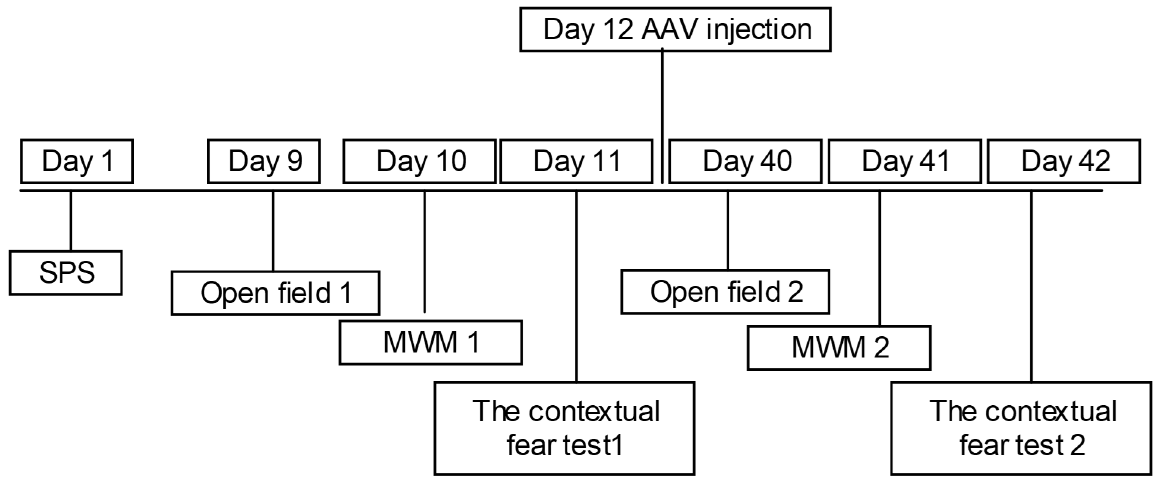
Figure 1. The design of the current study . To investigate whether SPS mice develops PTSD-like behaviors, the mice were randomly divided into sham (n = 18) and SPS (n = 36) groups. Open field test, MWM and contextual fear test were conducted on mice on day 9, 10 and 11, separately, after SPS induction. On day 12, some of the mice (n = 9 in sham group; n = 9 in SPS group) were sacrificed, and the hippocampal tissues were collected to detect the BHLHE40 protein levels. To investigate the functions of BHLHE40 on PTSD-like behaviors of mice, the remaining SPS mice were divided into 4 groups: sham (n = 9), SPS (n = 9), SPS+AAV-NC (n = 9), SPS+AAV-BHLHE40 (n = 9). Some of the mice were injected with AAV-NC and AAV-BHLHE40 on day 12. After injection of AAV for 28, 29, 30 days, open field test, MWM and contextual fear test were conducted, respectively. After injection of AAV for 30 days (42 days after SPS induction), mice were sacrificed, and the hippocampal tissues were